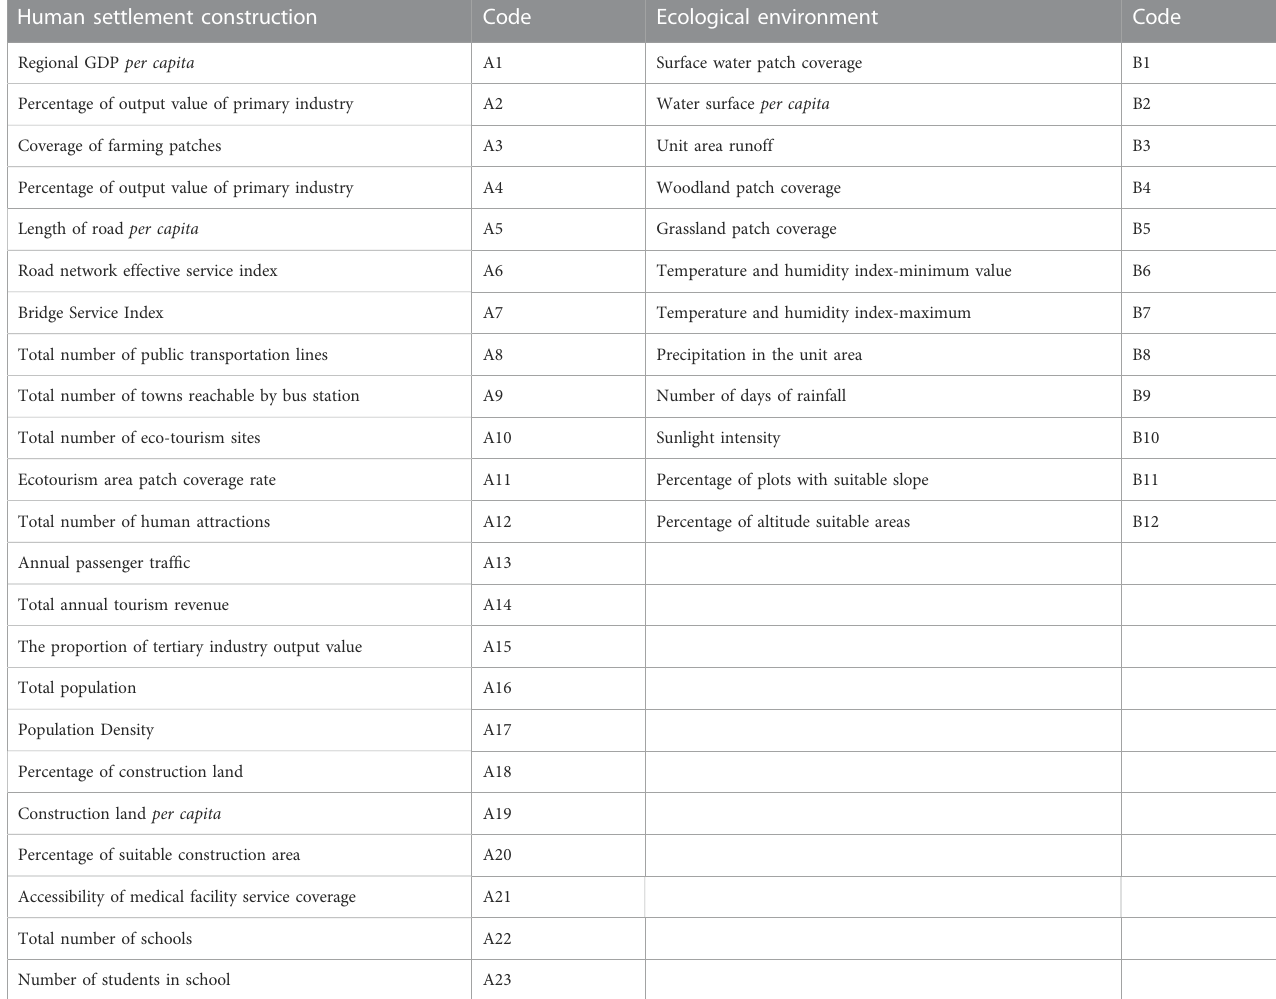
TABLE 1 Summary of explanatory variable